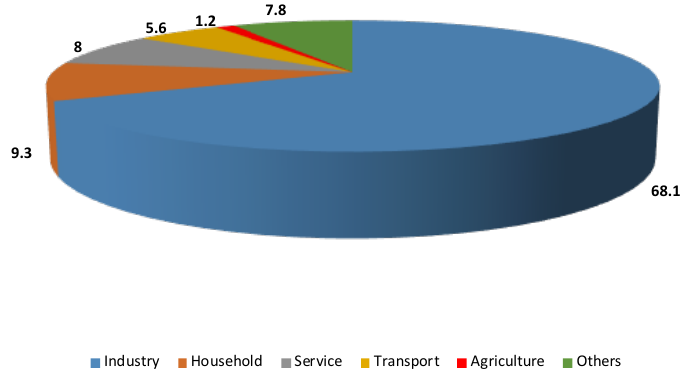
Figure 3. Electricity consumption by sectors in Kazakhstan. Data for figure from [36].